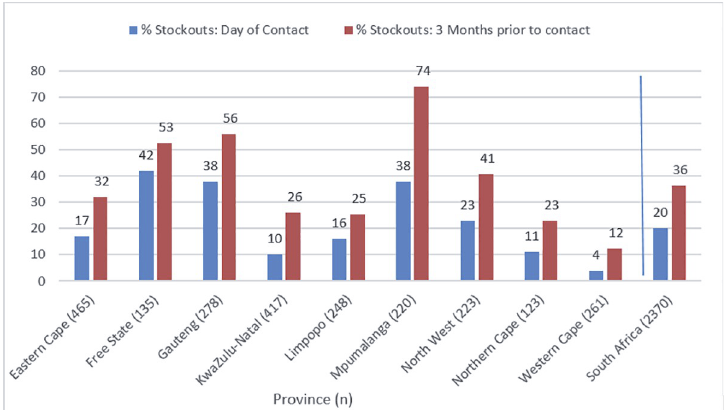
Fig 3. Percentage of facilities reporting at least one ARV or TB medicine stock-out on the day of contact and in the 3 months prior to contact by province and nationwide.